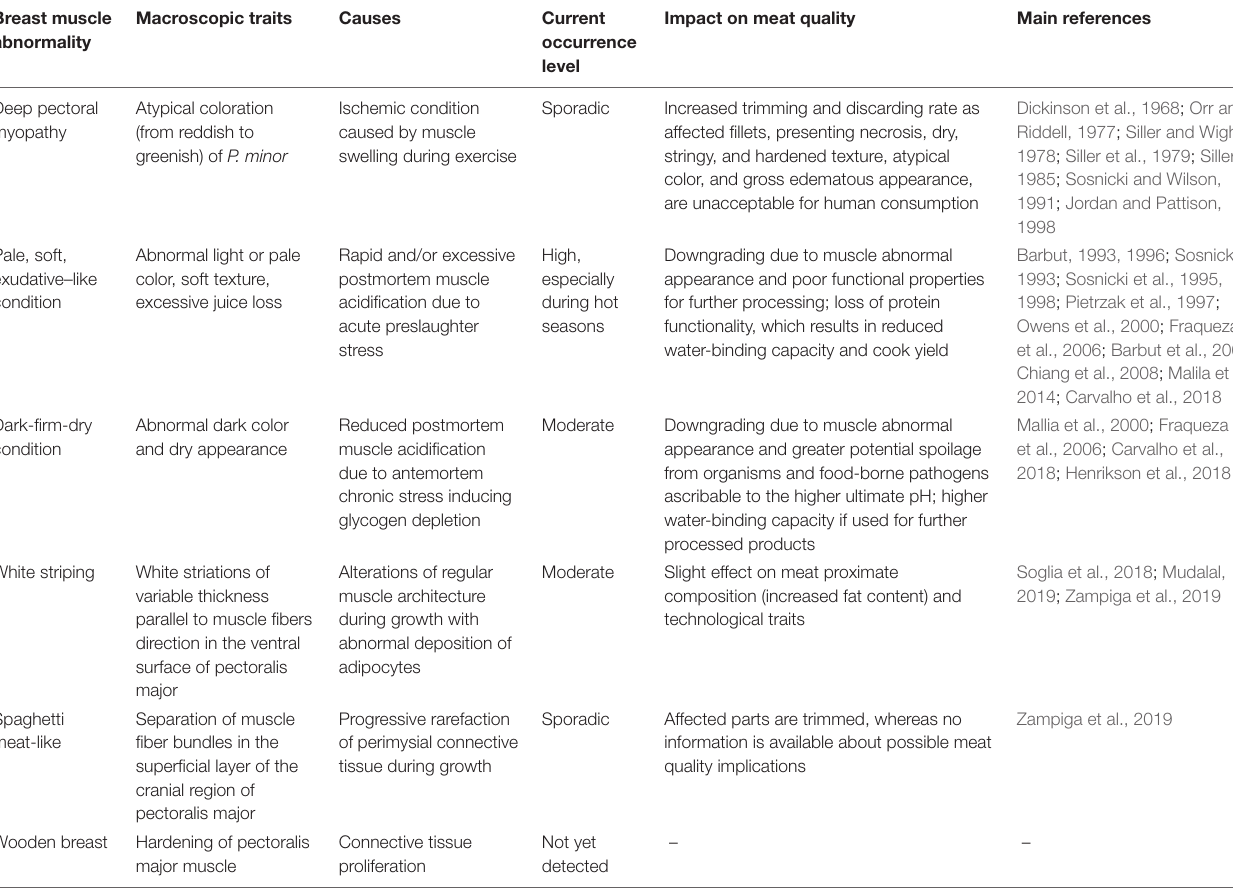
TABLE 1 | Description of the main breast muscle abnormalities in modern commercial turkeys and their impact on overall meat